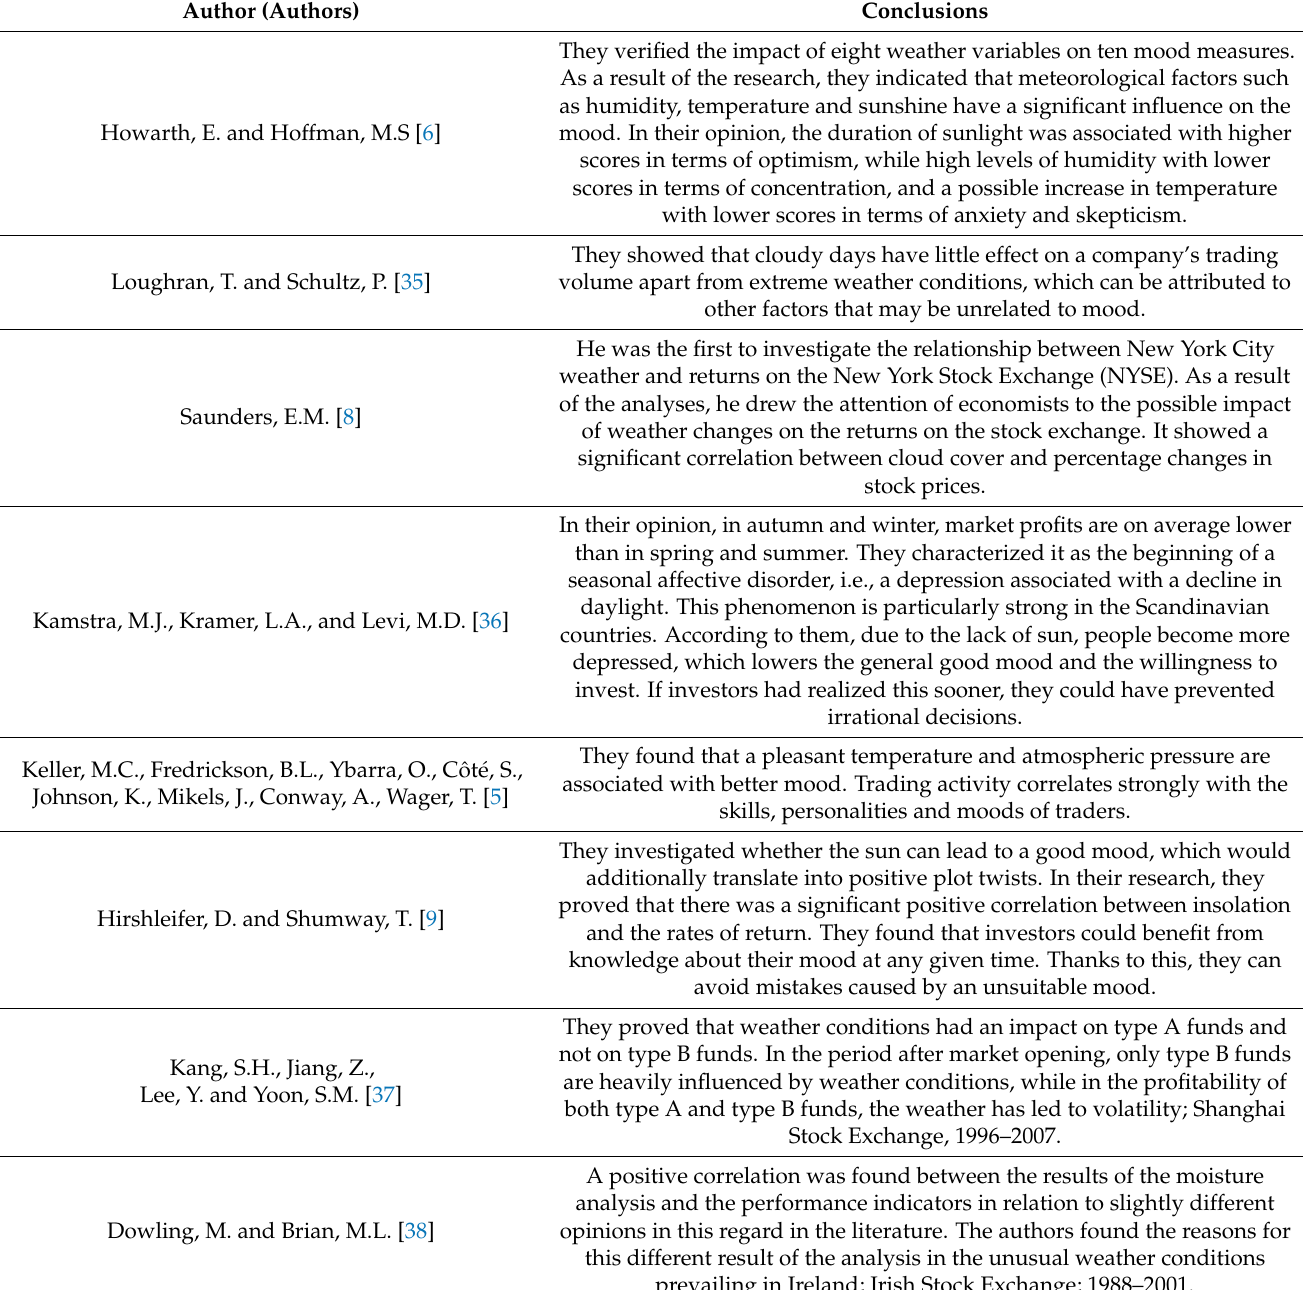
Table 1. Review of literature research on the emotions–weather–stock market